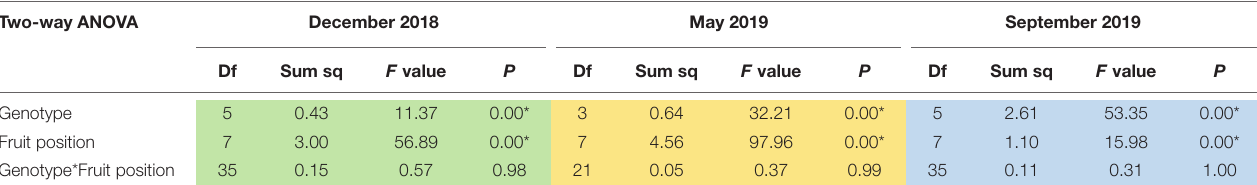
TABLE 1 | Results of two-way ANOVA and Tukey’s honestly significant difference (HSD) test examining the influence of genotype and fruit position along inflorescence on fruit weight in each replication. Two-way ANOVA